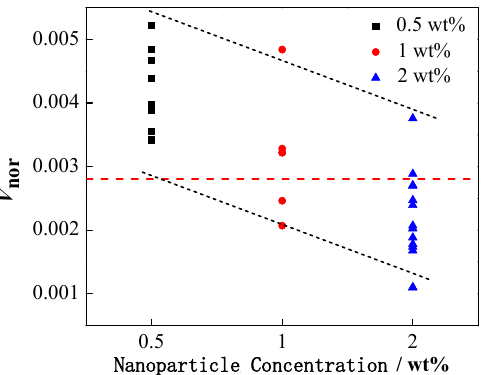
Figure 7. The relationship between the volume ratio of secondary and initial droplets and the concentration of NPs.